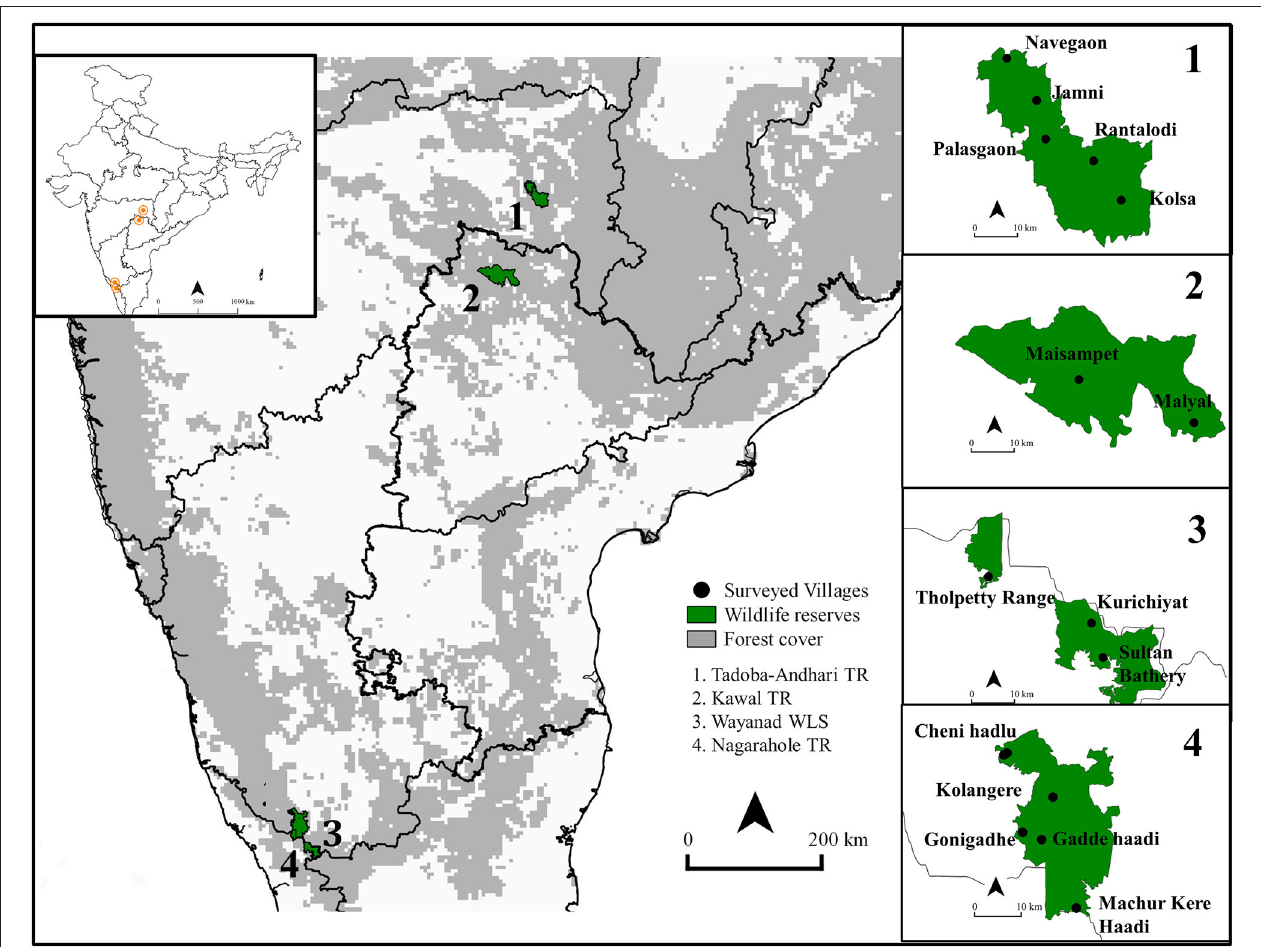
FIGURE 1 | Location of villages and PAs that were surveyed during the study. TR, Tiger Reserve; WLS, Wildlife Sanctuary.